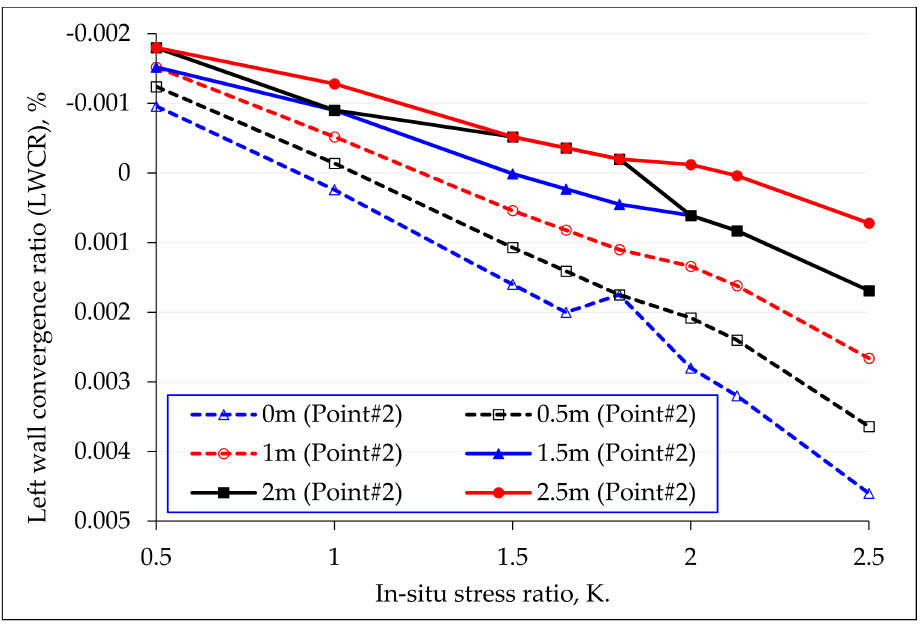
Figure 4. Ratio of convergence occurs in the tunnel left wall (RWCR) at various in situ stress ratios measured at different lateral distances from tunnel boundary (e.g., point #2).